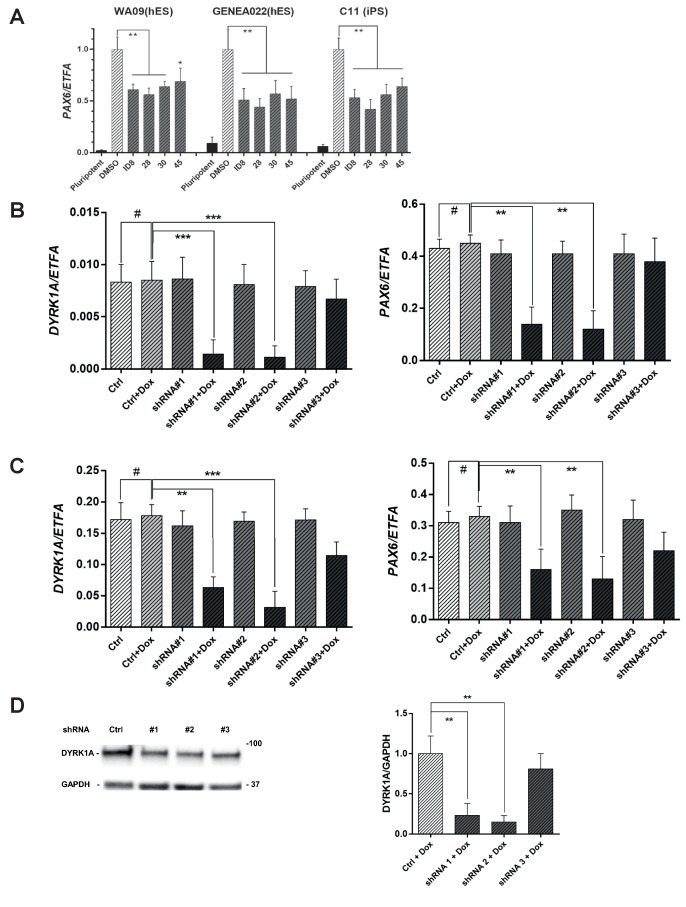
Inhibition of PAX6 induction after dual SMAD inhibitor treatment by DYRK1A inhibitors or inducible DYRK1A shRNA in hESC and hiPSC cell lines.(A) effect of DYRK1A inhibitors on induction of PAX6 expression following dual SMAD induction of neural specification in WA09, GENEA022, and C11 pluripotent stem cells. (B) effect of DYRK1A shRNA treatment on DYRK1A and PAX6 mRNA levels in GENEA022 hESC line; (C) effect of DYRK1A shRNA treatment on DYRK1A and PAX6 mRNA levels in C11 hiPSC line; (D) effect of DYRK1A knockdown on DYRK1A protein levels relative to that of GAPDH showing immunoblot (left) and results of densitometry analysis (right). A, B, and C show transcript levels relative to those of EFTA. *p<0.05; **p<0.01, ***p<0.001, using an unpaired two-tailed t-test with Welch’s correction.